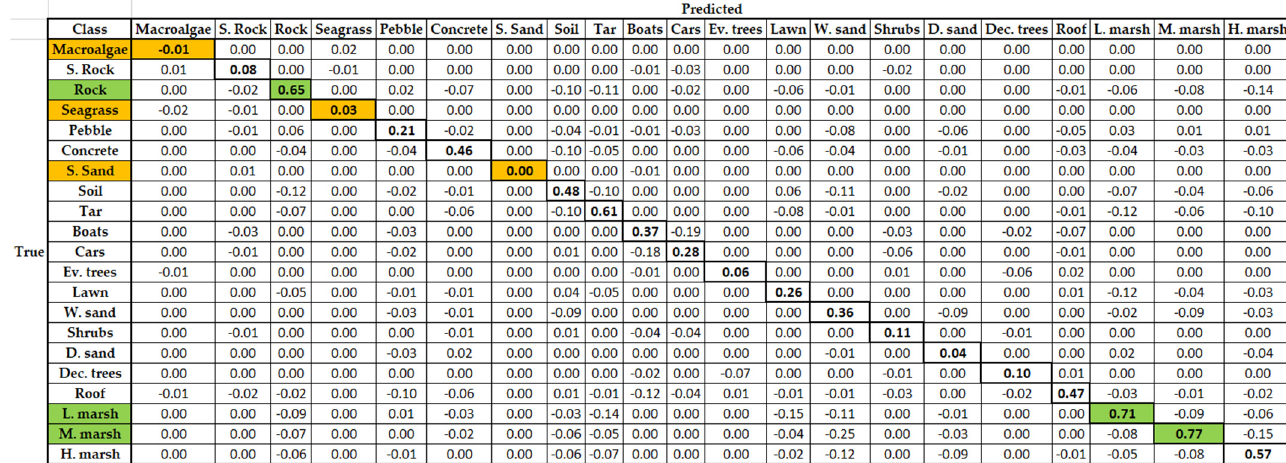
Figure A6. Difference of the confusion matrixes obtained for the classification of green waveforms’ features plus elevations, and green waveforms’ features only. The three highest and three lowest values are highlighted in green and orange, respectively. S. = submerged, Ev. = evergreen, Dec. = deciduous.